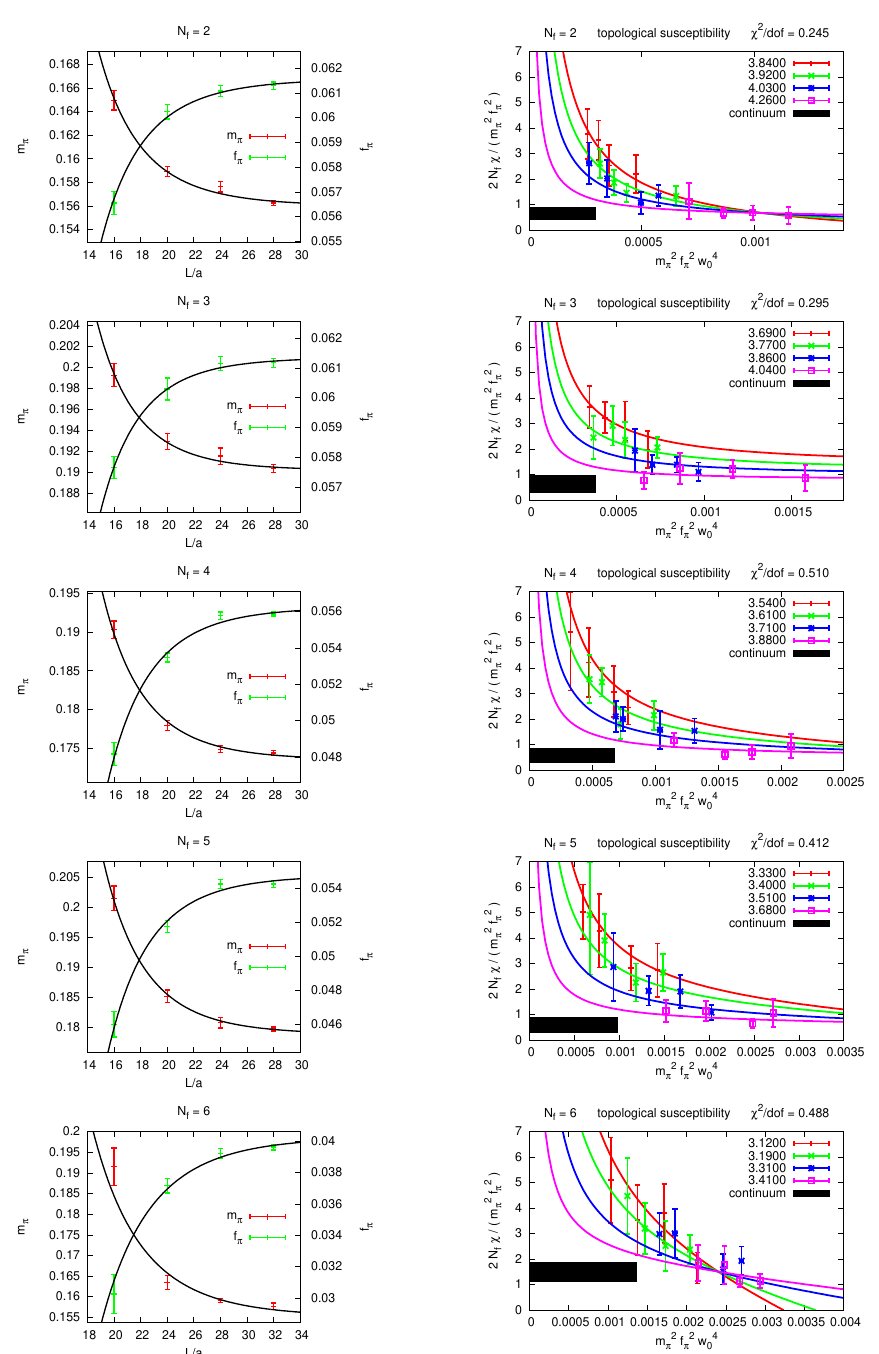
Figure 2 . Left: in(cid:12)nite volume extrapolations of m (cid:25) and f (cid:25) , based on table 2. Right: chiral- continuum extrapolation of the topological susceptibility. The ratio 2 N f (cid:31)= ( m 2 is expected to be constant 1 at leading order of chiral perturbation theory; see text for more